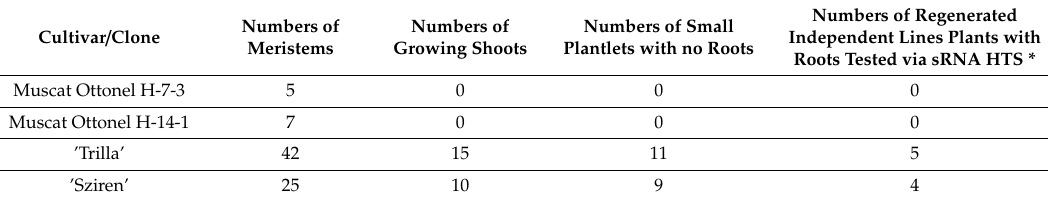
Table 4. Results of the meristem in vitro cultures.